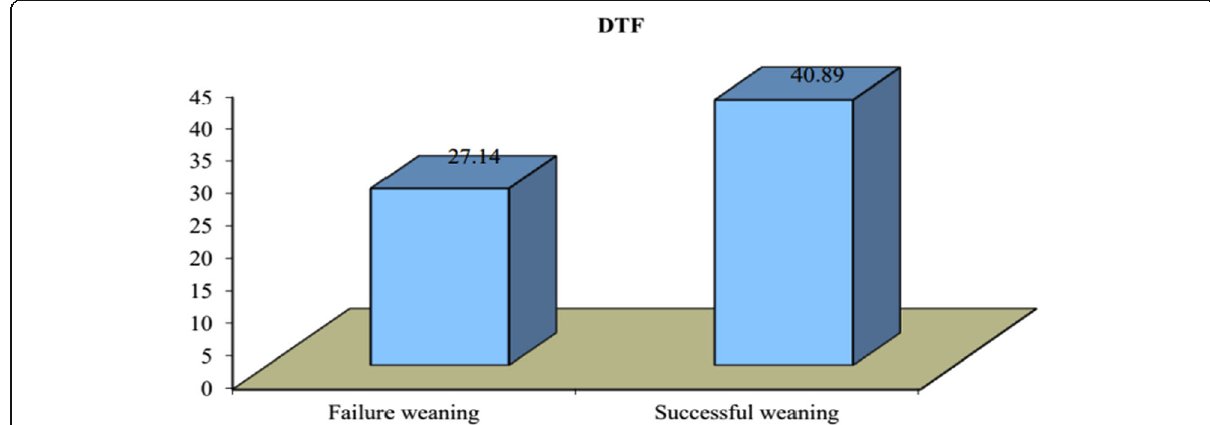
Fig. 4 Bar of mean showing comparison between failure weaning group and successful weaning group regarding DTF. DTF diaphragm thickness fraction